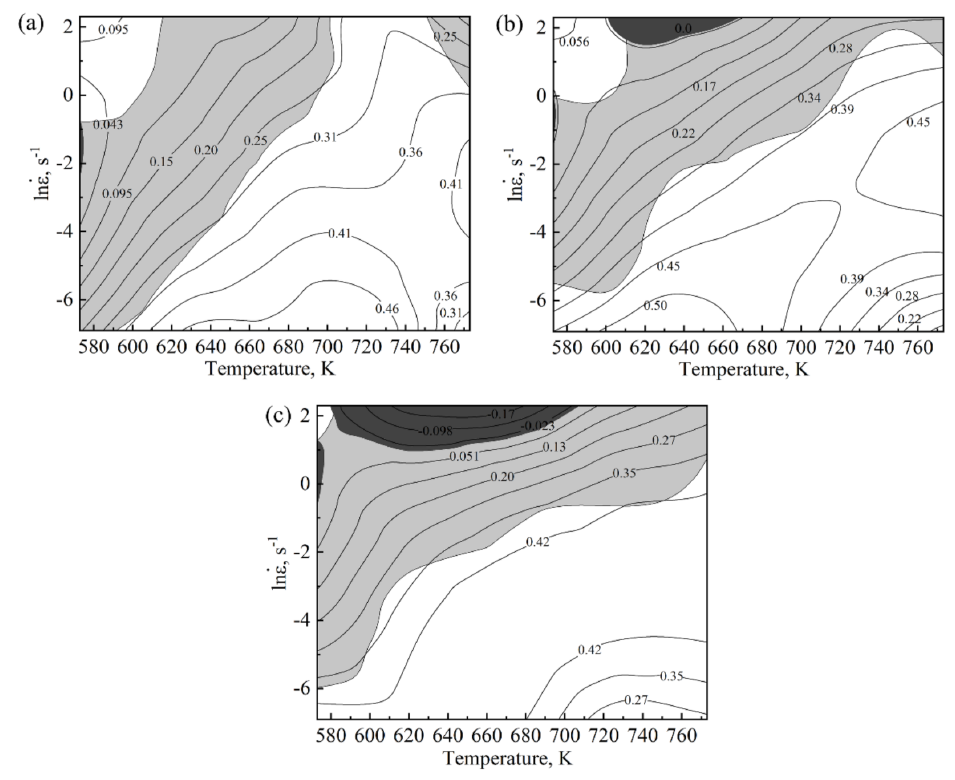
Figure 10. The processing map of the Mg-2.5Nd-0.5Zn-0.5Zr alloy, ( a ) ε = 0.1, ( b ) ε = 0.3, ( c ) ε =